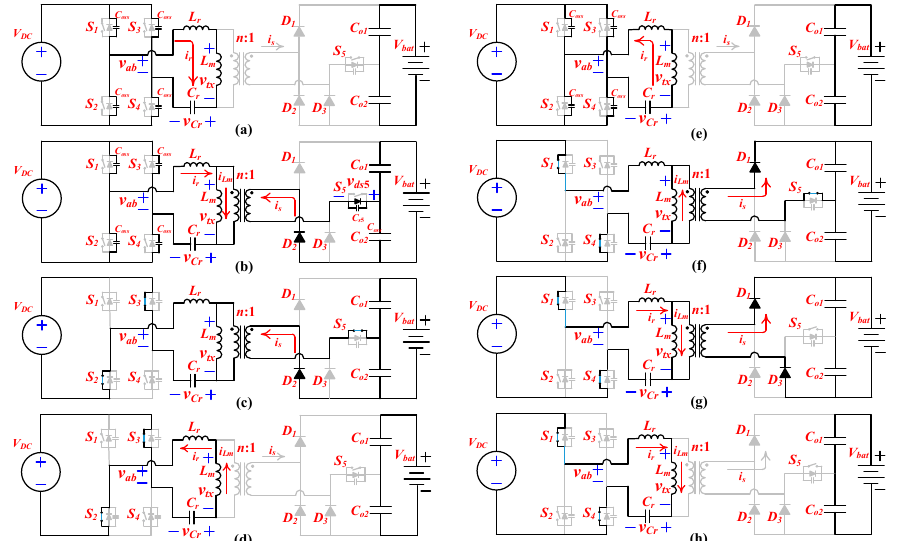
Figure 4. Converter equivalent circuits in PWM Mode: ( a ) Stage I, t 0 ≤ t < t 1 ; ( b ) Stage II, t 1 ≤ t < t 2 ; ( c ) Stage III, t 2 ≤ t < t 3 ; ( d ) Stage IV, t 3 ≤ t < t 4 ; ( e ) Stage V, t 4 ≤ t < t 5 ; ( f ) Stage VI, t 5 ≤ t < t 6 ; ( g ) Stage VII, t 6 ≤ t < t 7 ; ( h ) Stage VIII, t 7 ≤ t < t 8 .